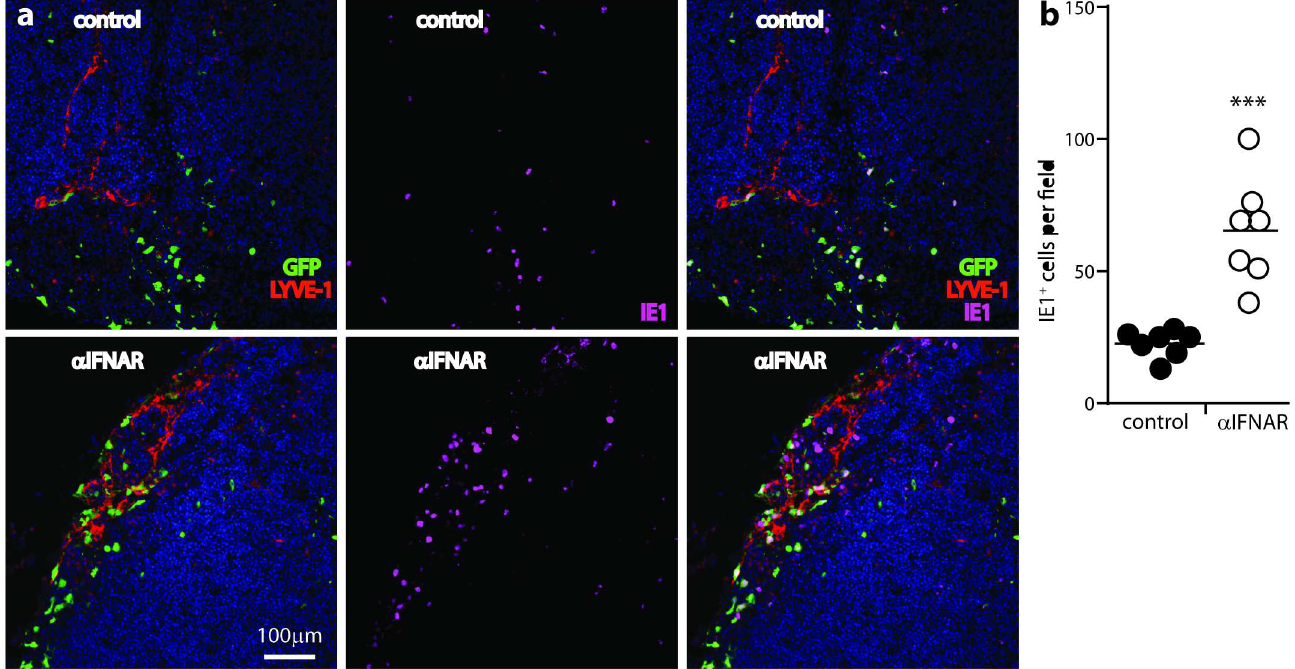
Fig 4. IFNAR blockade increasesMCMV lytic infection in LN. C57BL/6mice were given IFNAR blockingantibody ( α IFNAR) or not (control), then MCMV-GR i.f. (10 6 p.f.u.). PLN taken 1 day later were stained for viral GFP, MCMV IE1 antigen, and LYVE-1 (lymphaticendothelium). ( a) shows examplesof staining.( b) shows quantitation, countingIE + cells for 7 fields of view in PLN sectionsfrom each of 3 mice per group. Circles show individualmeans, bars show group means. α IFNAR significantly increasedIE + cell numbers (Student’stwo tailedunpairedt-test with Welch’s Correction; *** , P <